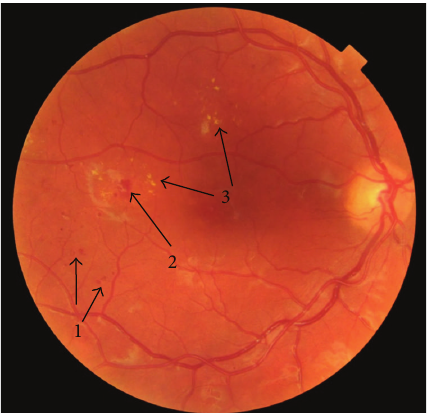
Figure 1: Image of 28-year-old patient with T1DM and DR (1: microaneurysms, 2: hemorrhages, and 3: hard